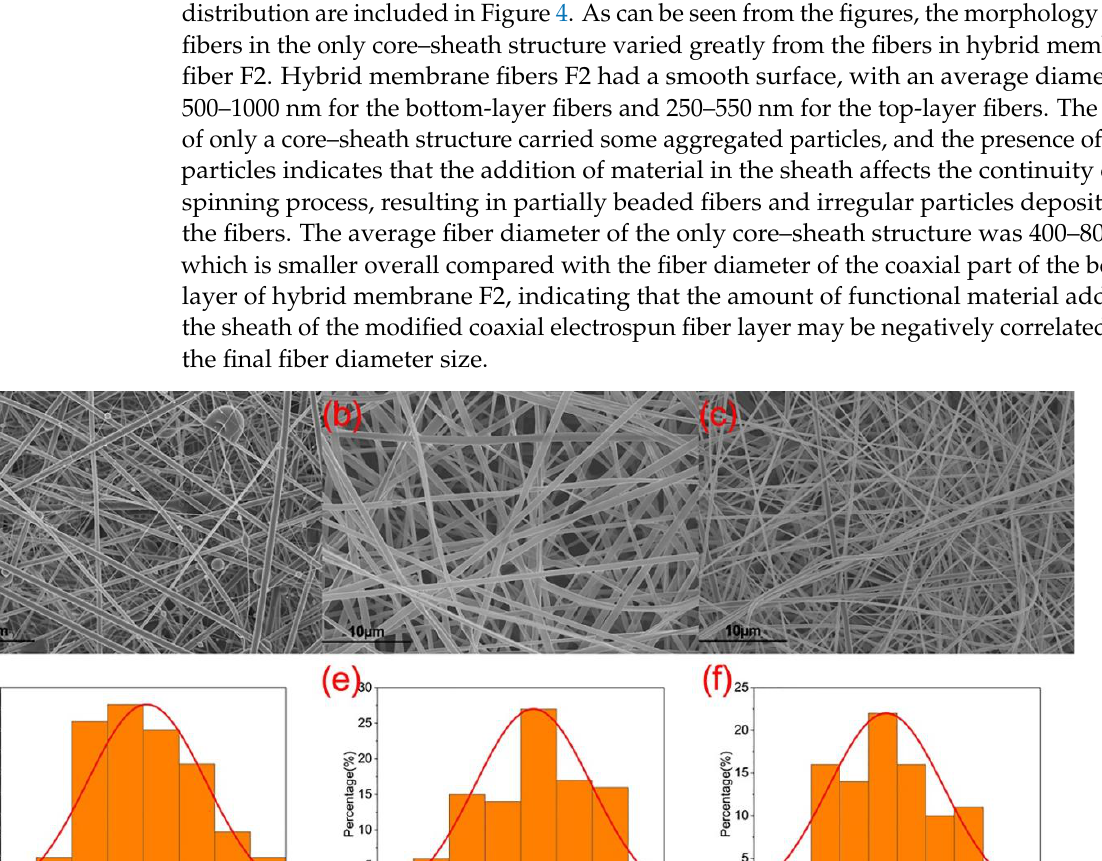
tion of core–sheath nanofiber F1 (the down-left inset shows a typical Taylor cone); ( d ) a sin-